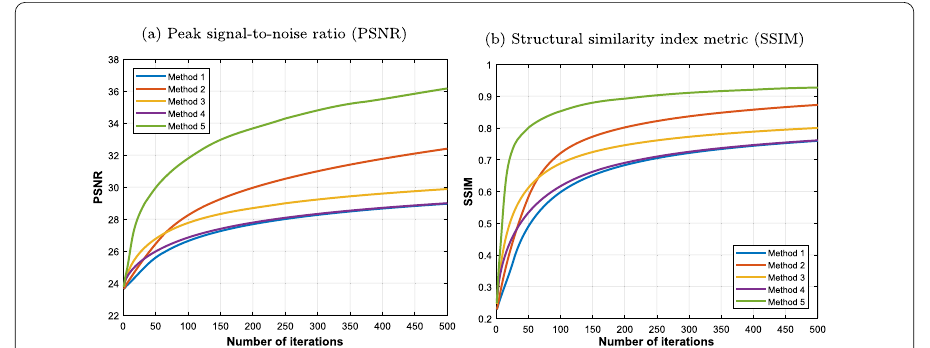
Figure 5 Plot of PSNR and SSIM of restored images by Methods 1–5